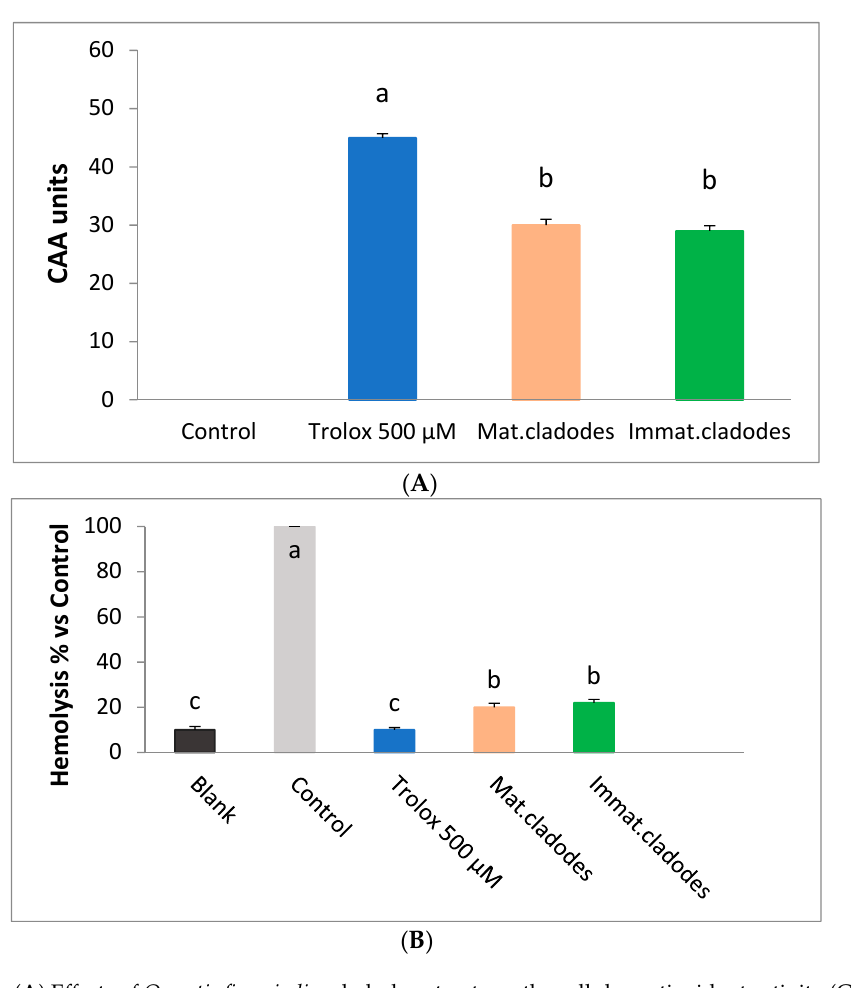
Figure 2. ( A ) Effects of Opuntia ficus-indica cladode extracts on the cellular antioxidant Figure 2. ( A ) E ff ects of Opuntia ficus-indica cladode extracts on the cellular antioxidant activity (CAA) in activity (CAA) in human erythrocytes. Trolox was used as reference standard. ( B ) Effects human erythrocytes. Trolox was used as reference standard. ( B ) E ff ects of Opuntia ficus-indica cladodes of Opuntia ficus-indica cladodes extracts on 2,2 ′ -Azobis (2-methylpropionamidine) extracts on 2,2 (cid:48) -Azobis (2-methylpropionamidine) dihydrochloride (AAPH)-induced hemolysis in dihydrochloride (AAPH)-induced hemolysis in human erythrocytes. Trolox was used as human erythrocytes. Trolox was used as reference standard. Assays were carried out in triplicate reference standard. Assays were carried out in triplicate and the results were expressed as and the results were expressed as mean values ± SD. Di ff erent letters indicate significant di ff erences mean values ± SD. Different letters indicate significant differences ( p ≤ 0.05). One-way ( p ≤ 0.05). One-way ANOVA with Bonferroni’s multiple comparison ANOVA with Bonferroni’s multiple comparison test.